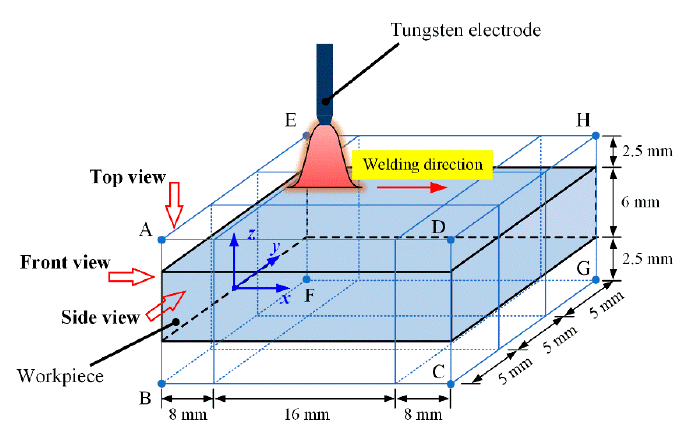
Figure 2. Initial state of the VP-GTAW model.